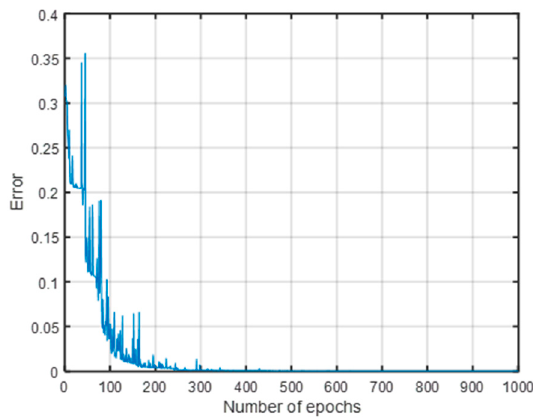
Figure 11. Error to iterations of the fault location training set.